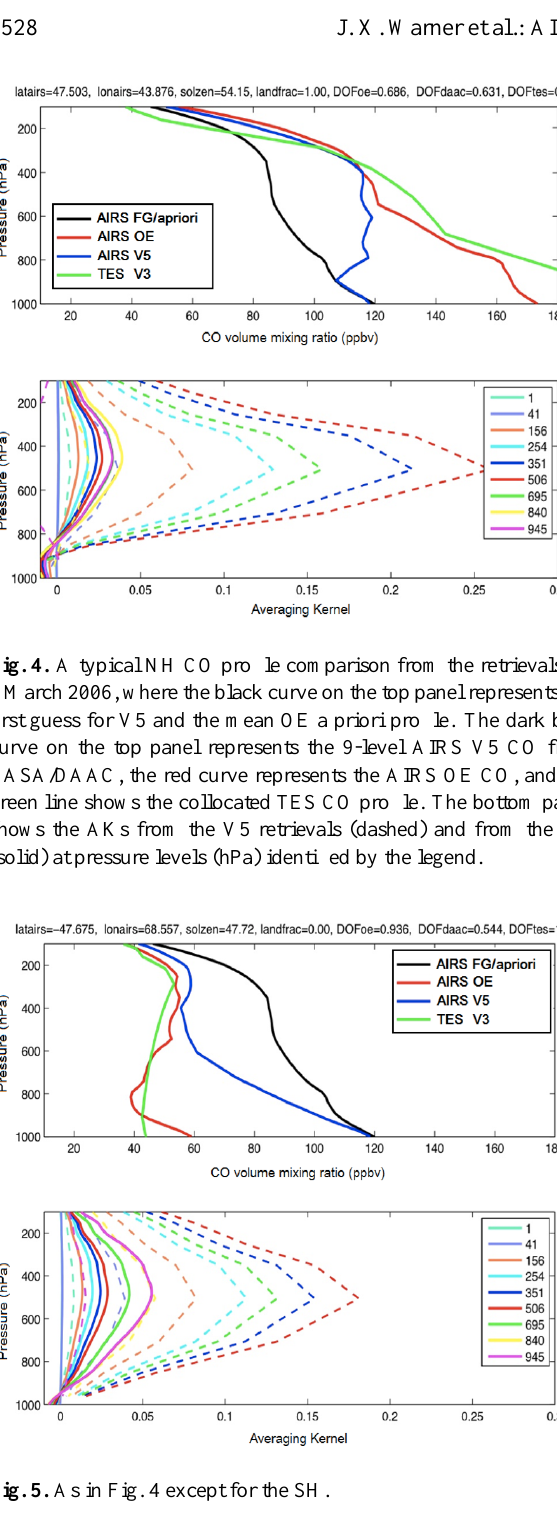
information is obtained in the mid-troposphere between 400 and 600 hPa for both the AIRS operational algorithm and the OE.